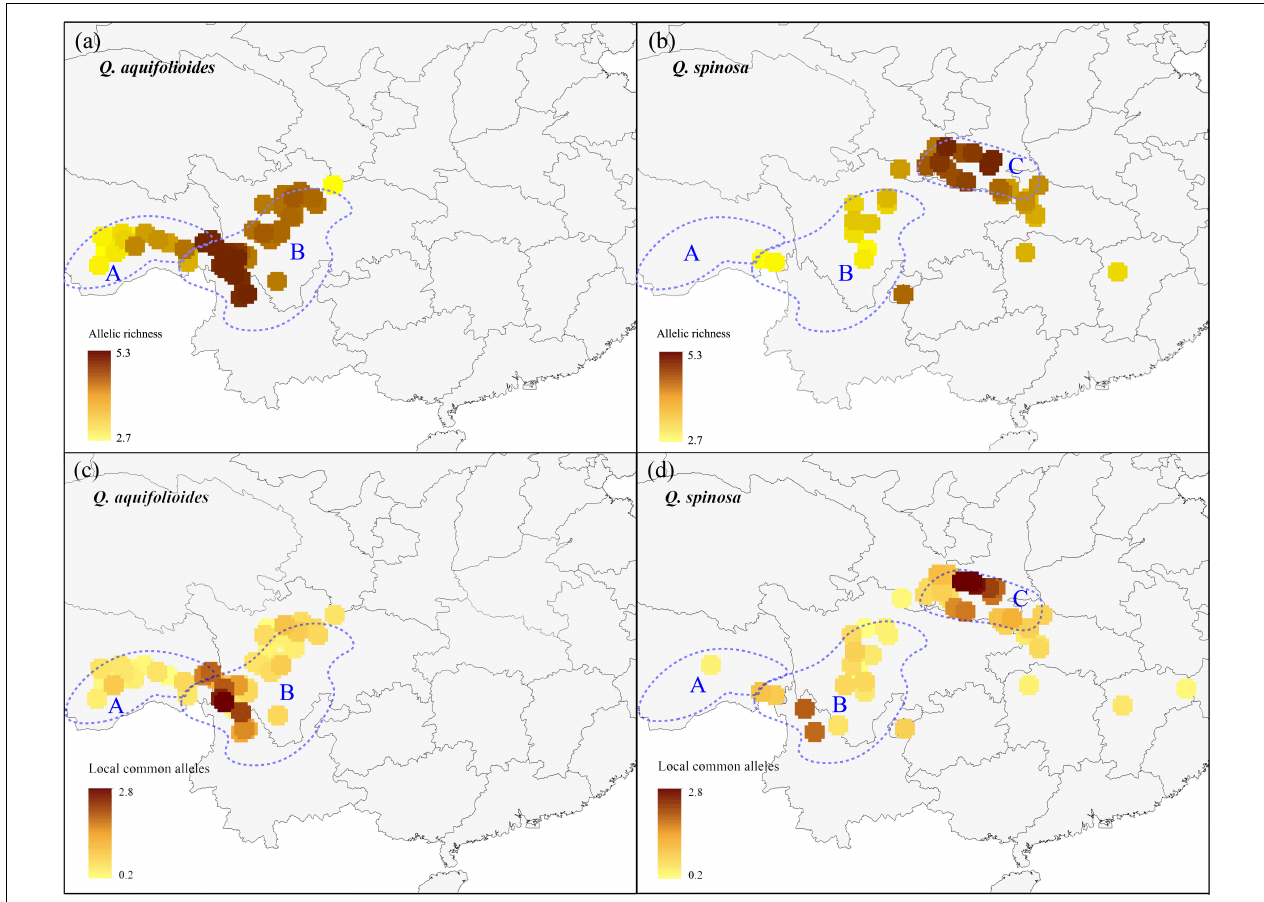
FIGURE 2 | The allelic richness and locally common alleles map of Q. aquifolioides and Q. spinosa. The light blue dotted lines represent defined three research areas: (a) Qinghai–Tibet Plateau (QTP); (b) Hengduan Mountains (HDM); (c) Qinling Mountains (QM).